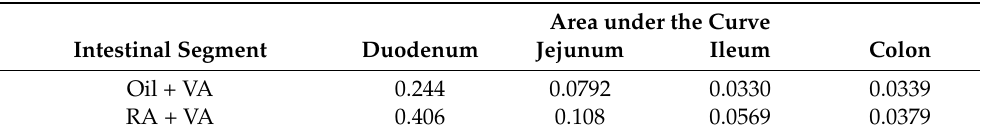
Figure 4. Regional distribution of fraction of ingested dose (FD) vs. time after administration of 3 H- labeled VA supplement in neonatal rats: ( A ) Duodenum; ( B ) Jejunum; ( C ) Ileum; ( D ) Colon. Data are presented as means ± SEM, n = 4–6 pups/time/group. * indicates statistically significant differ- ence between groups, p < 0.05. Table 4. 3 H labeled VA accumulation in each intestinal segment after VA supplementation with and without RA pretreatment. Area under the Curve Intestinal Segment Duodenum Jejunum Ileum Colon Oil + VA 0.244 0.0379 0.0792